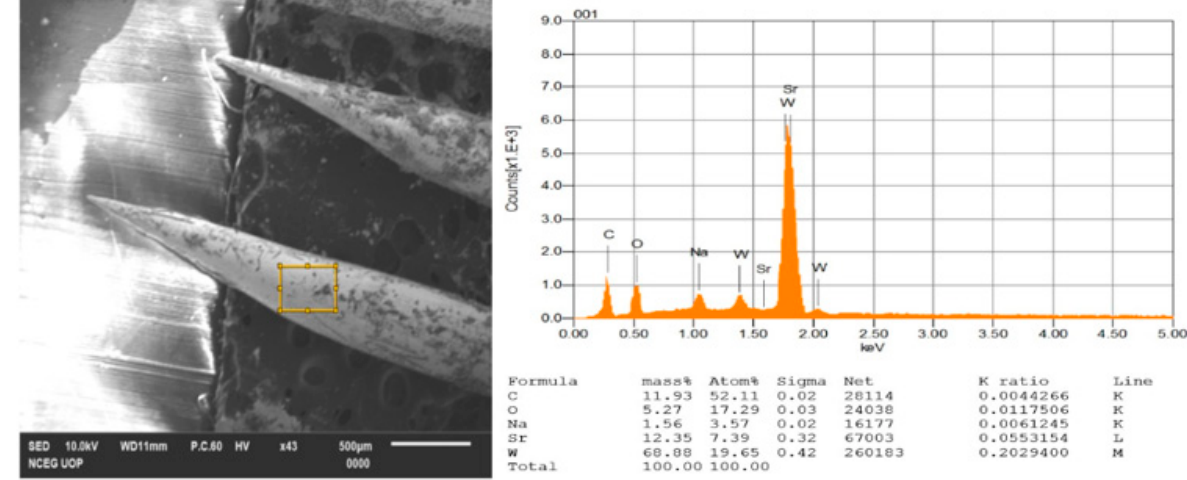
Figure 10. Energy Dispersive X-Ray (EDX) results for a heavily contaminated tungsten tip. After the result of the first EDX analysis, which shows contaminations and oxidation, so we have performed a second EDX analysis for tungsten tip rinsed with distilled water, iso-propanol and lastly in concentrated Hydro fluoric (HF) acid, which have removed some of the contaminations and tungsten oxide layer present. Moreover, tungsten tips need to be stored in a vacuum chamber after rinsing for better results. The results of the second EDX analysis are shown below in Figure 11, which consists of 95.11 percent of tungsten and 4.89 percent of carbon, the rest of the oxide layers have been removed.